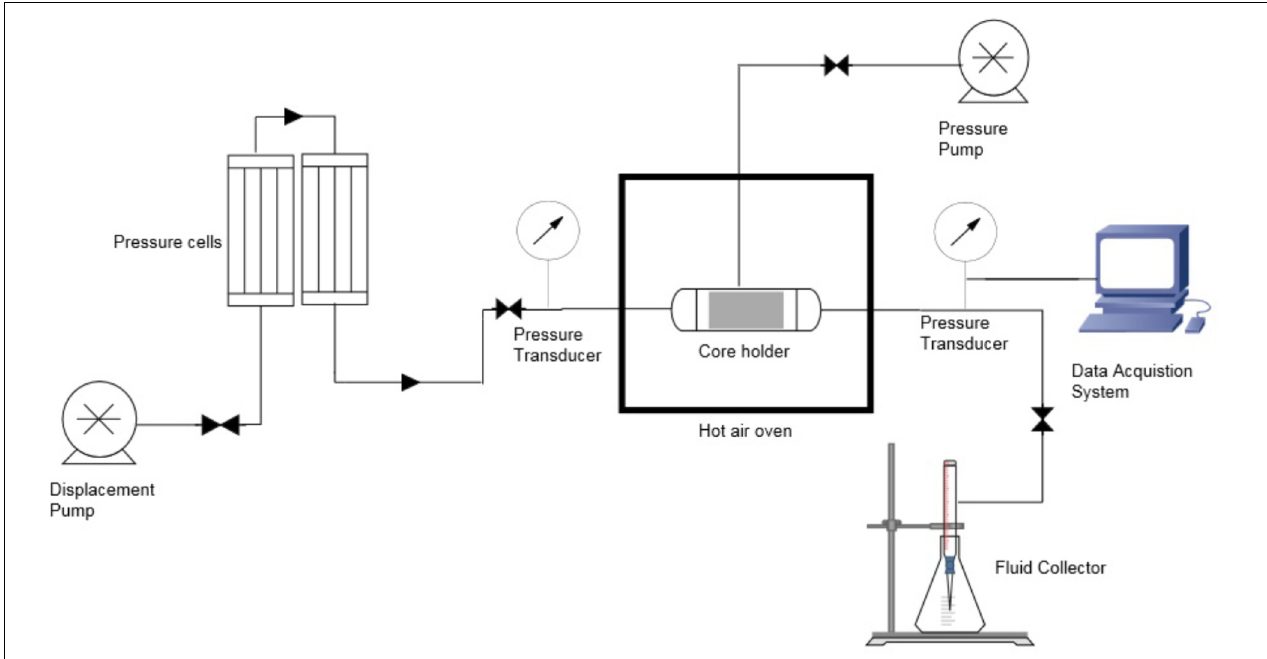
FIGURE 2 | Schematic diagram of core flood